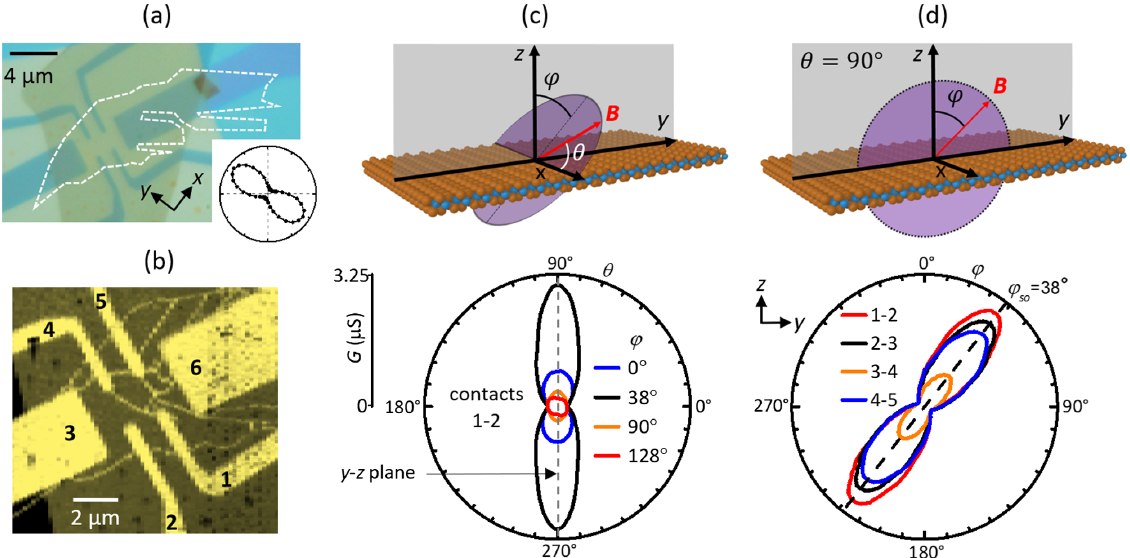
3.).FIG. 2. Sensitivity of edge conduction in monolayer WTe 2 to magnetic field orientation. (a) Optical microscope image of device MW5. The monolayer WTe 2 flake is outlined with a white dashed line. Inset: polar plot of the polarized Raman A 1 mode intensity used to determine the x and y crystal axes. (b) Image of the device obtained using microwave impedance microscopy to map the local ¼ 0 , and B ¼ 0 ), revealing edges and cracks as thin bright lines. (c) Polar plot of conductance G between conductivity ( T ¼ 4 K, V g contacts 1 and 2 as the magnetic field B (of strength B ¼ 3 T) is rotated in the manner indicated in the sketch above ( T ¼ 4 K